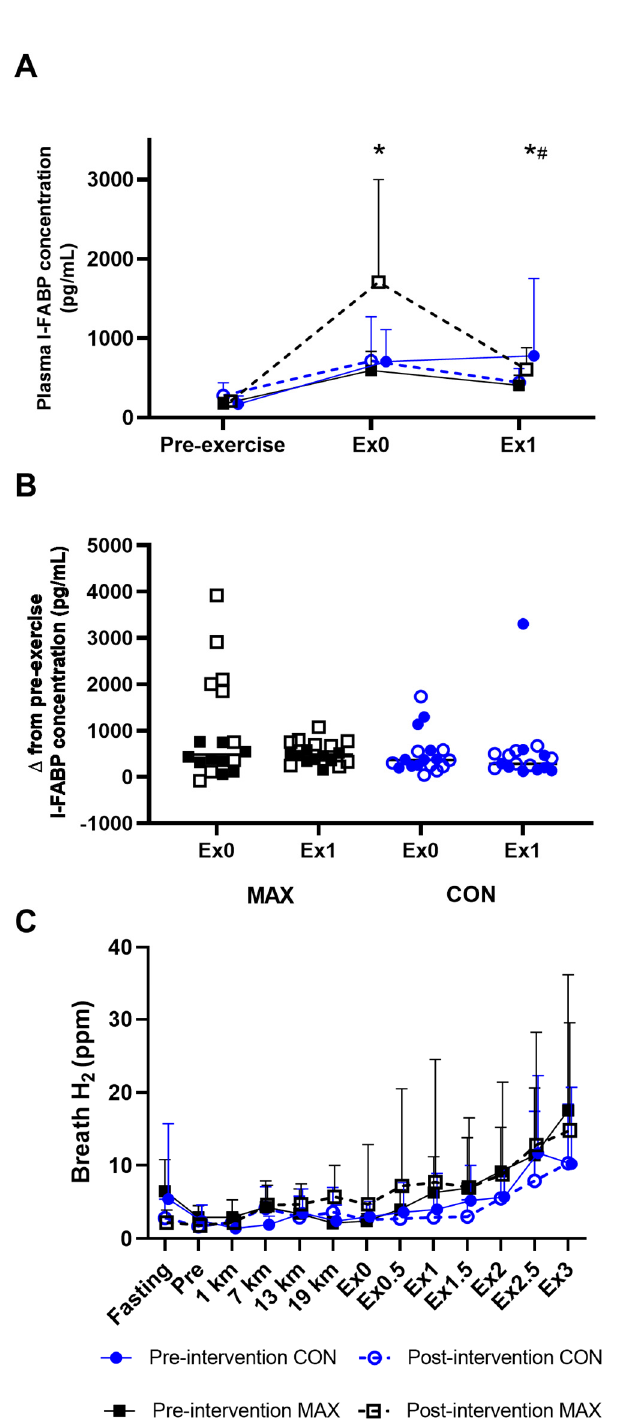
Figure 2. Mean ( A ) and individual changes ( B ) in plasma I-FAPB concentration pre- and post- a 26-km race walking session, and ( C ) mean breath H 2 values pre-, during, and post-session in elite race walkers before (pre-intervention) and after (post-intervention) a protocol to increase endogenous and exogenous CHO availability (MAX), compared with a control condition (CON) involving moderate CHO availability. Data are mean and standard deviations; * = significant increase from pre-exercise. # = significant decrease from Ex0. Ex0: immediately post-exercise; Ex followed by numeral represents time (in hours) post exercise ending: e.g., Ex1: 1 h post-exercise; ∆ (delta): change in reported variable